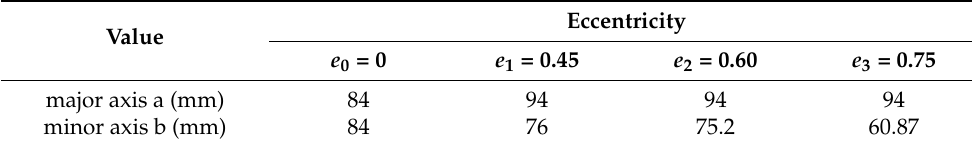
Table 1. Structural parameters of rotating drums.